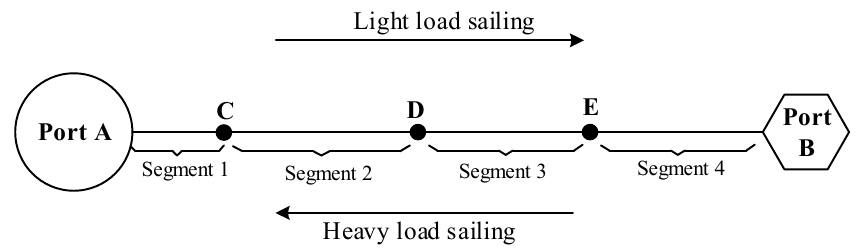
Figure 2. Illustration of a medium- and long-distance inland voyage.